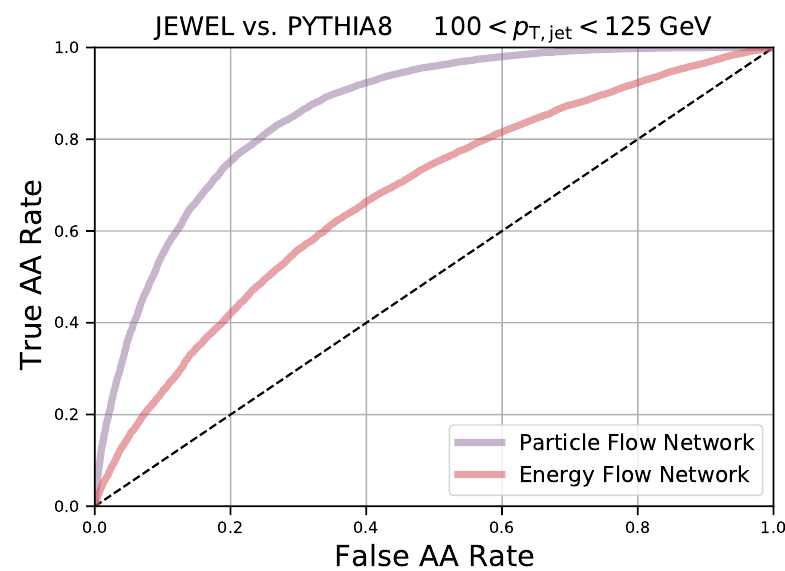
Figure 2 . Classification performance of pp vs. AA jets quantified in terms of ROC curves using IRC-unsafe PFNs and IRC-safe EFNs. The jet samples in pp and AA collisions are obained from Pythia 8 [70] and Jewel [72,